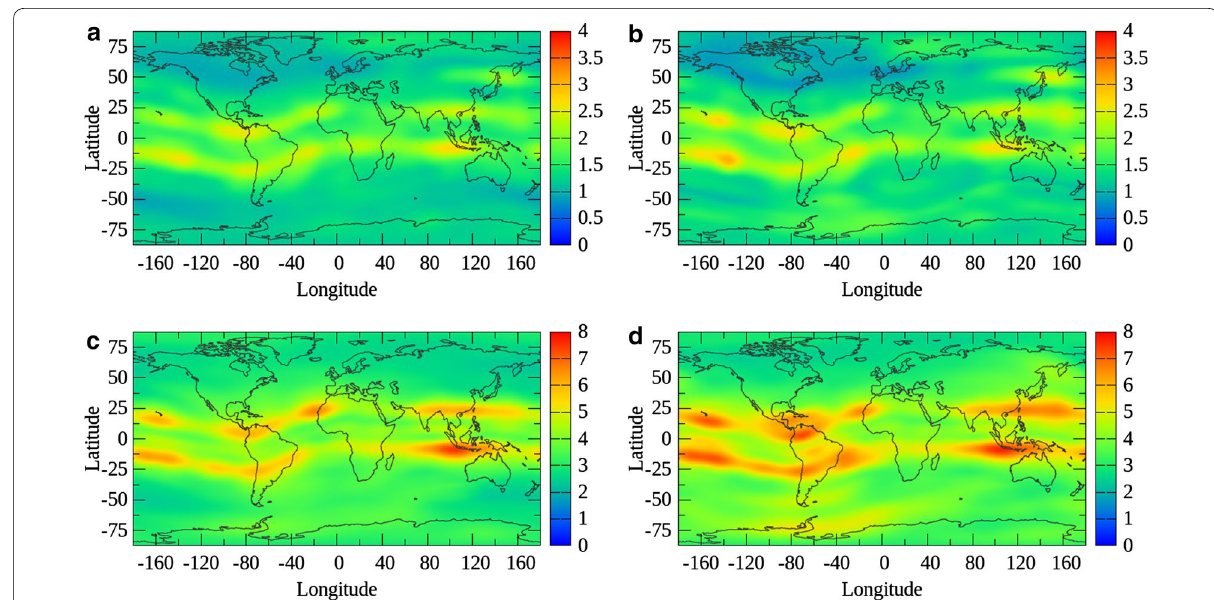
Fig. 9 RMS values of the differences between forecasting products ARPG and C1PG, and the final CODG product in 2009 and 2015. a RMS of ARPG minus CODG in 2009. b RMS of C1PG minus CODG in 2009. c RMS of ARPG minus CODG in 2015. d RMS of C1PG minus CODG in 2015